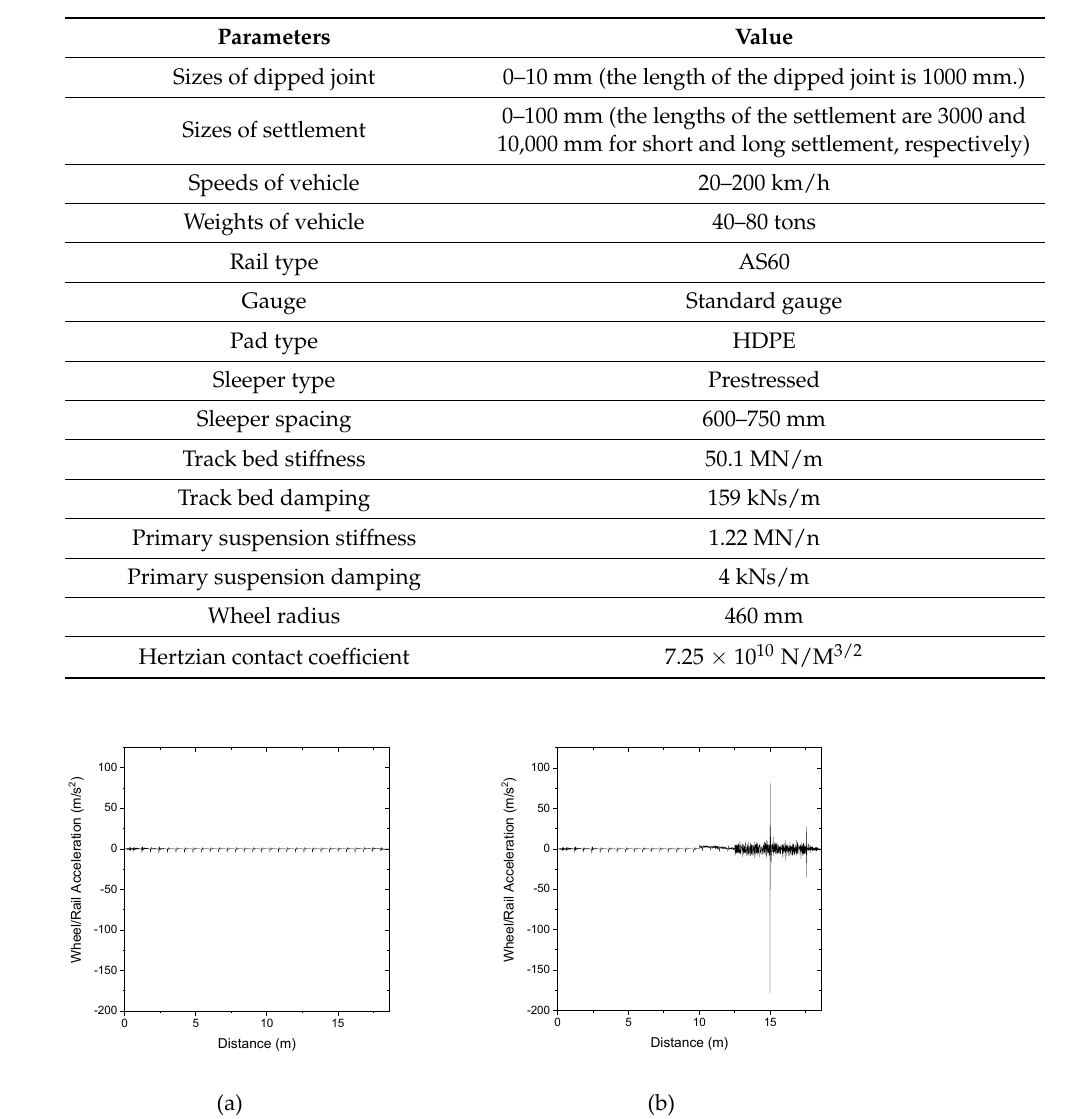
Table 2. A summary of varied parameters in D-Track.